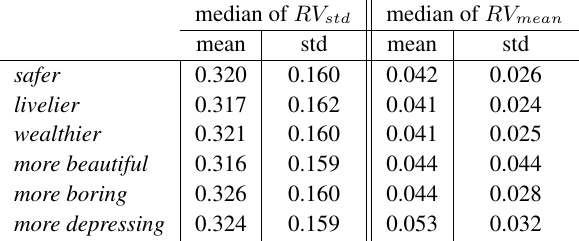
Table 1. Aggregated values of the median of RV std